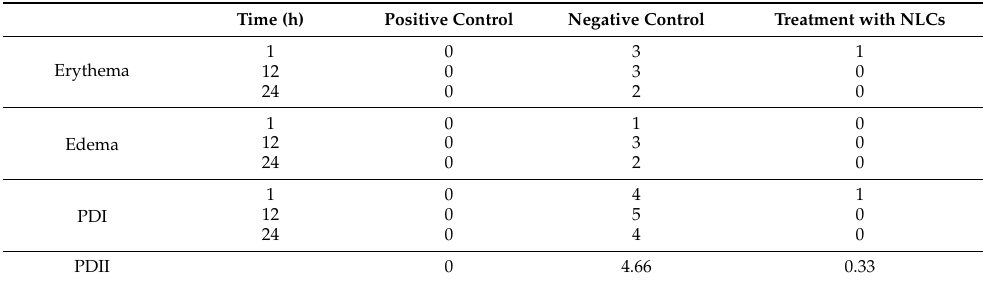
Table 2. Draize scoring analysis of rat skin treated with FLU–ACT-coloaded NLC gel, 0.8% formalin and